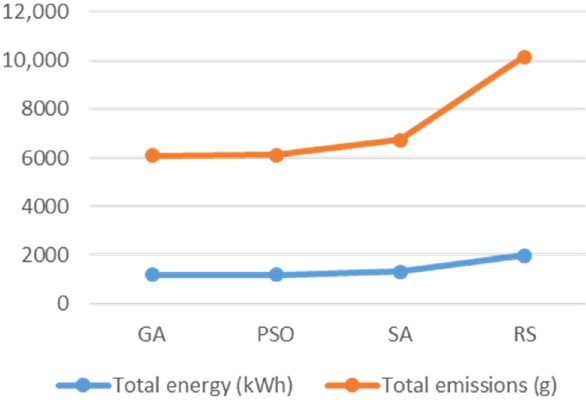
Figure 11. Total energy and emissions of the case of twenty